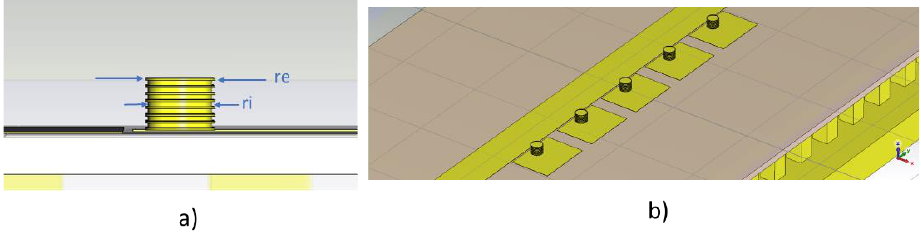
Figure 13. Detail of the model implemented for the screw: ( a ) screw thread in the air layer with internal radius (ri) and external radius (re) ( b ) resonators with modeled screws for the 5-cell EBG filter.